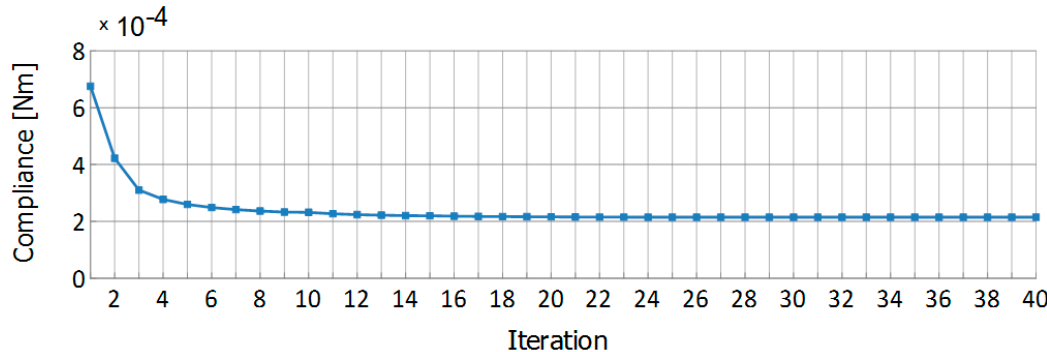
Figure 9. Selected middle topologies and the final one for the introductory example—for the last iteration, the grid has not been shown, to improve the clarity of the picture.